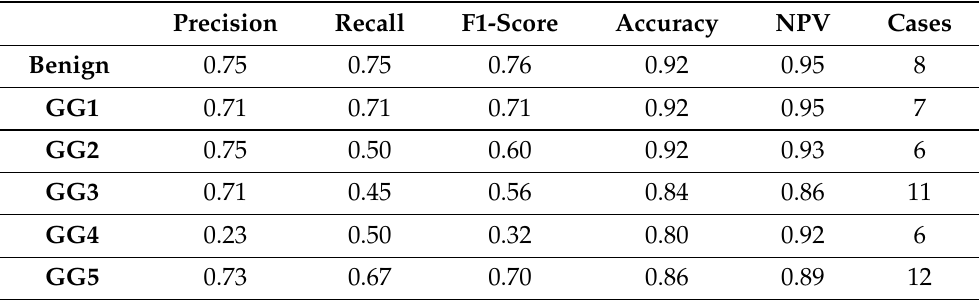
Table 4. Grade groups classification of our CAD system using precision, recall, F1-score, accuracy, and negative predictive value